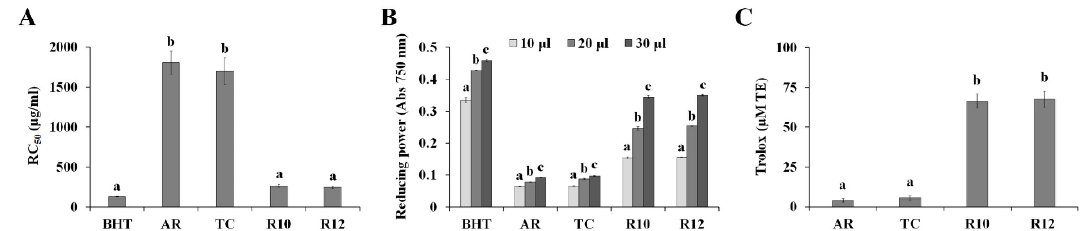
Figure 4. Antioxidant activities of PAP1 -overexpressing ginseng hairy roots were measured by DPPH-free radical scavenging ( A ), reducing power ( B ), and ORAC ( C ) assays. DPPH-radical scavenging activity was calculated as RC 50 . The ORAC values of each extract are expressed as µ M of Trolox equivalents. The bars represent the mean ± SE of three independent experiments. Values in the same column with di ff erent superscripted letters are significantly di ff erent ( p < 0.05). Transgenic lines: R10 and R12; Transgenic control: TC; Ginseng adventitious root: